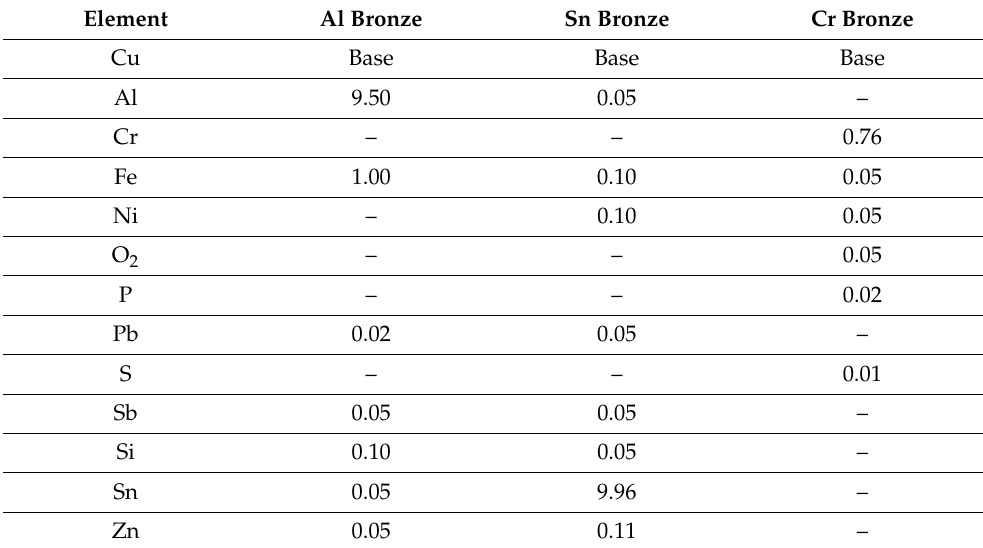
Table 1. Chemical compositions of bronzes (wt.%).